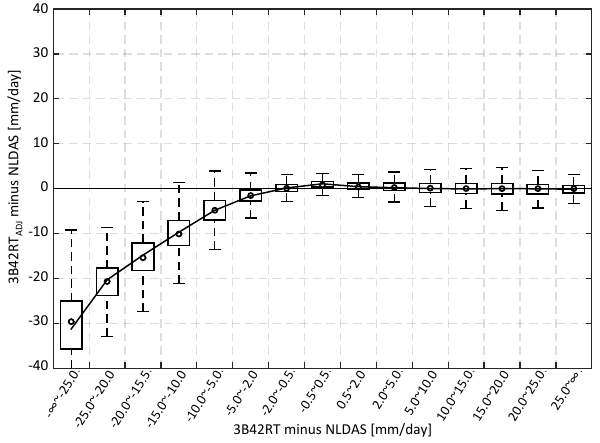
Figure 11. Distribution of 3B42RT and 3B42RT ADJ precipitation error compared to NLDAS. Statistics are provided in Table